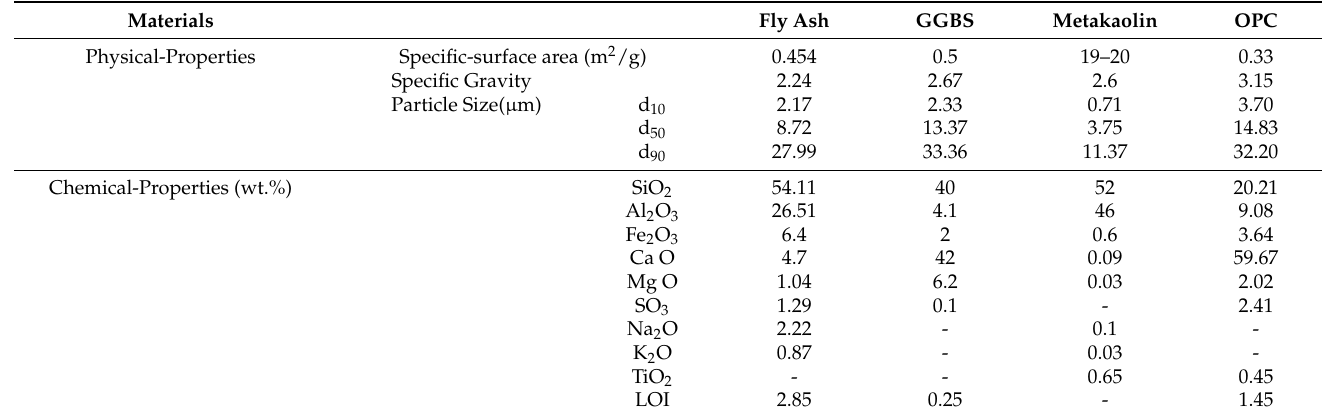
Figure 1. Particle-size distribution of binders. Table 1. Physical and chemical properties of binders.